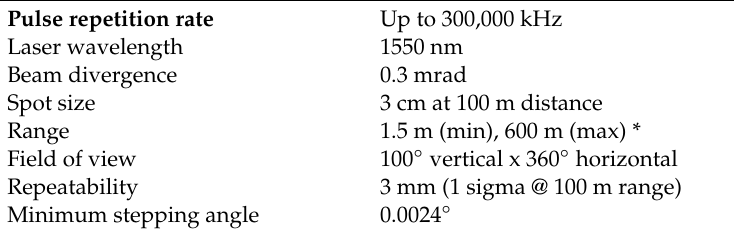
Table 1. Riegl VZ-400 factory